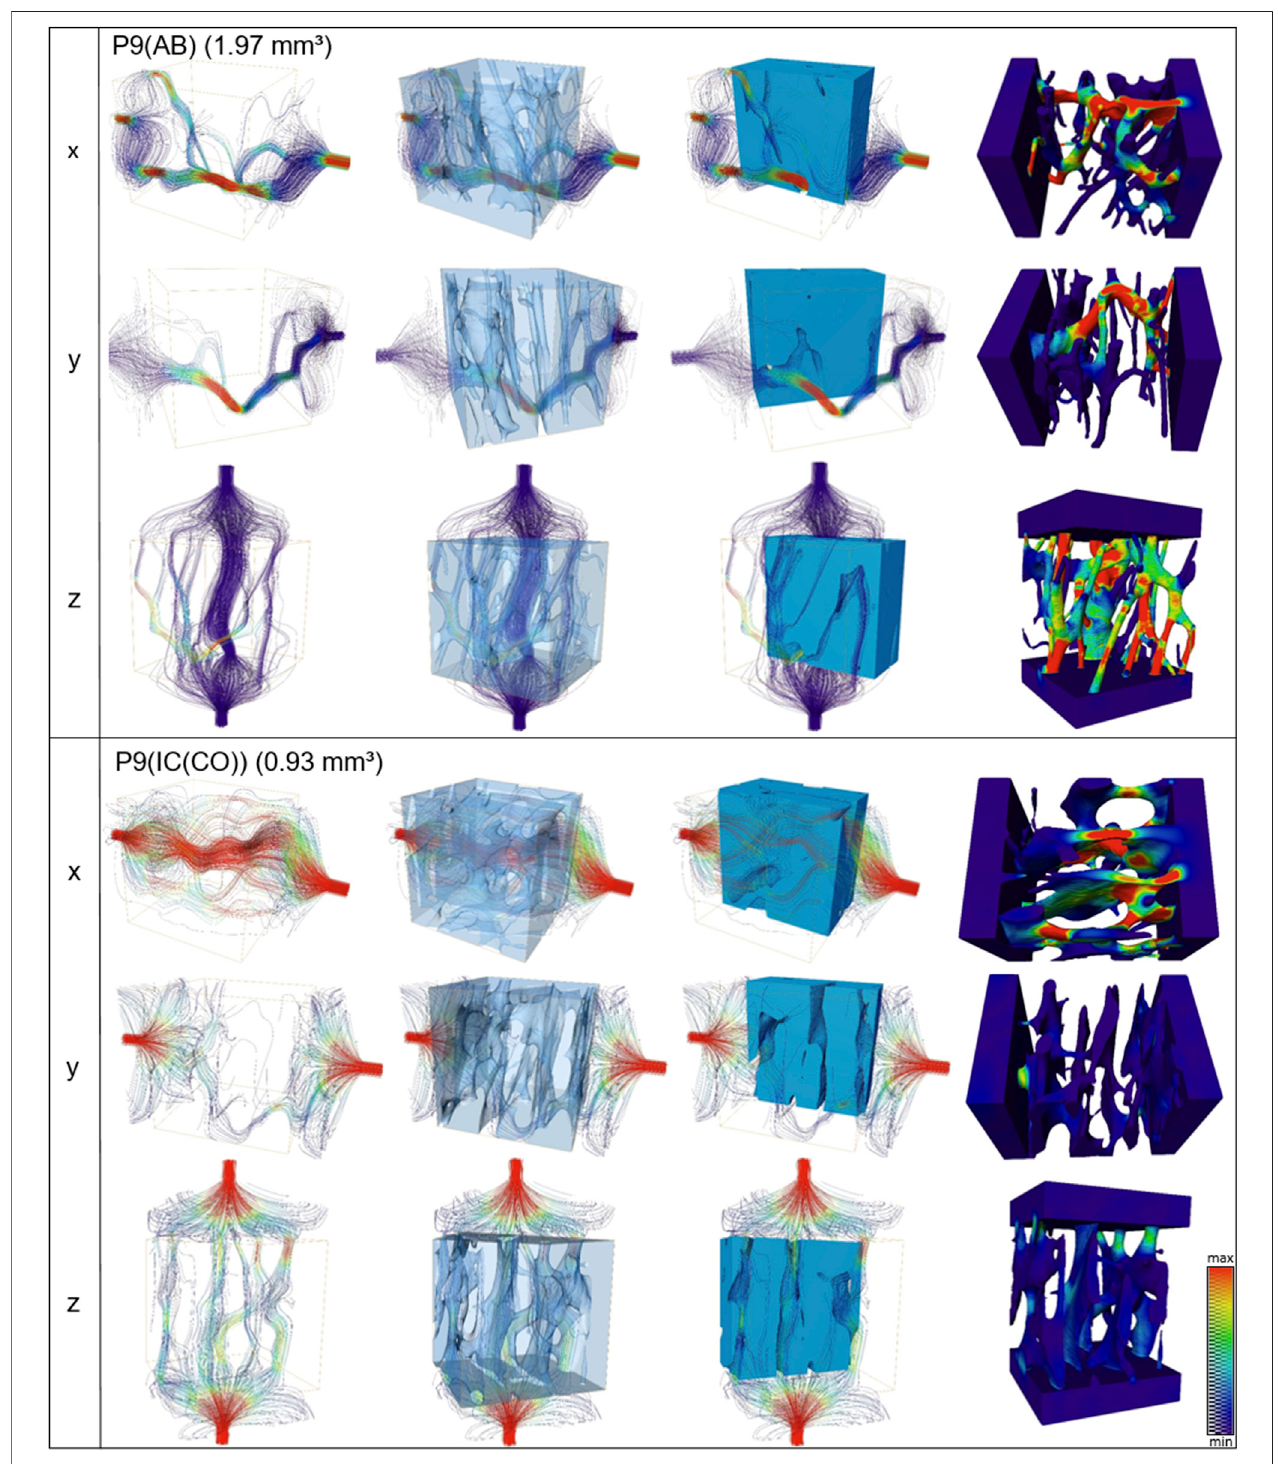
FIGURE6| Streamline ( fi rstthreecolumns)and velocities(lastcolumn)of fl uidsimulations performedalongx,y,and zaxes foralveolar andiliaccrestofonepatient (P9). The absolute permeability values of this patient are shown in Table 3 .